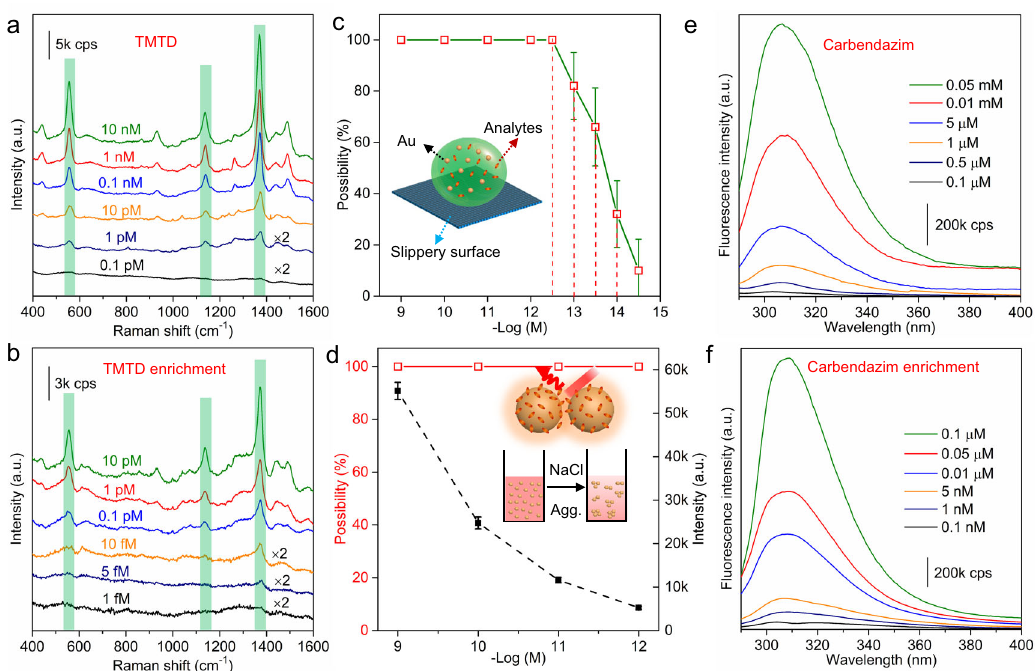
Fig. 4 Application in Raman and fl uorescence detection by this enrichment strategy. Enhanced Raman spectra of TMTD a before and b after enrichment process of MN-PCDP. c Probability of SERS signals with different concentrations of TMTD after enrichment process of MN-PCDP by hydrophobic slippery SERS platform. The inserted schematic diagram shows hydrophobic slippery SERS platform. The data are reported as the average enrichment of fi ve experiments. Error bars mean standard deviations. Shaded areas mean the characteristic peaks (555, 1138, and 1370 cm − 1 ) of TMTD molecule. d Detection probability (red) and intensity of SERS signals (black) with different concentrations of TMTD after enrichment process of MN-PCDP by aggregating approach with Au colloid. The inserted schematic diagram shows aggregating approach with Au colloid. The data are reported as the average enrichment of fi ve experiments. Error bars mean standard deviations. Fluorescence spectra of carbendazim e before and f after the enrichment of MN-PCDP.